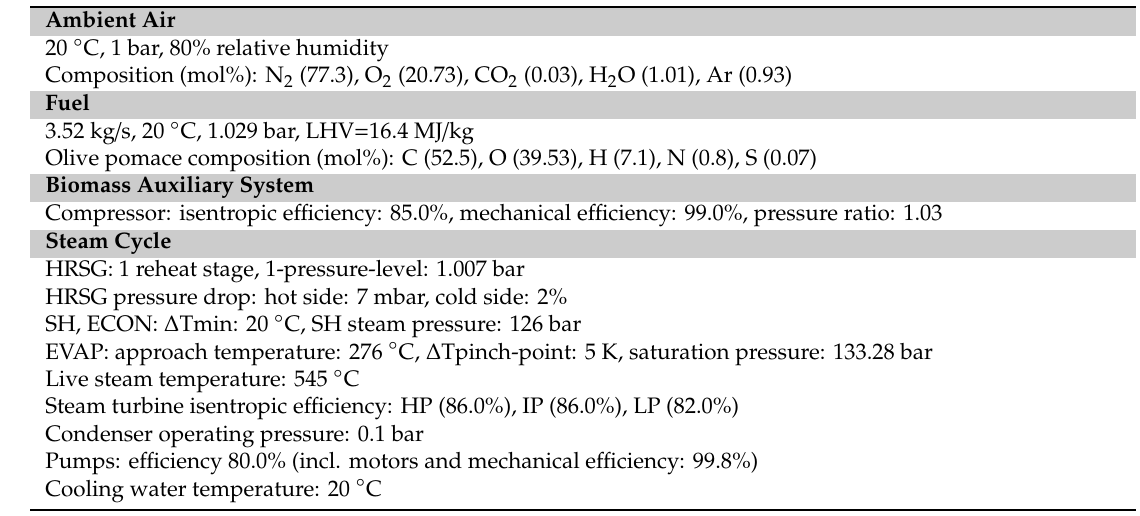
Table 1. Power block operational parameters.